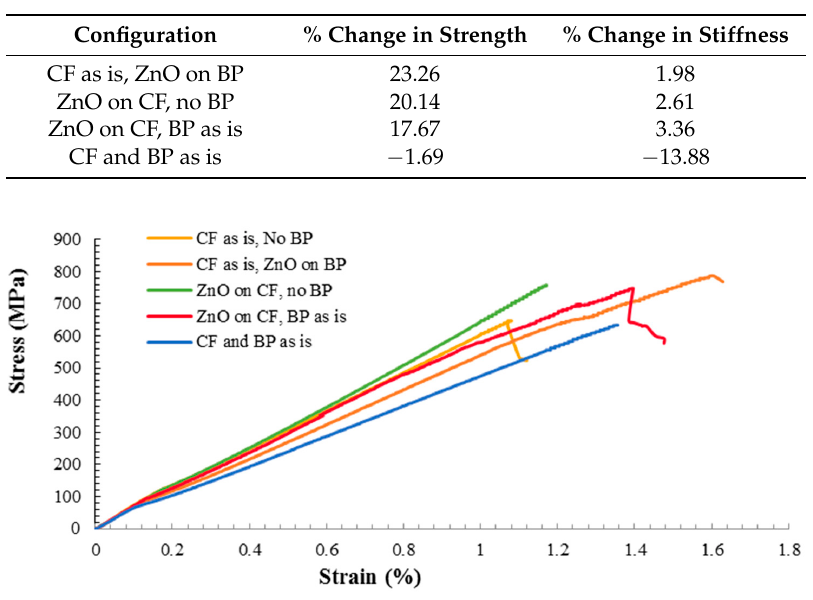
Figure 4. Comparison of tensile test data of various configurations